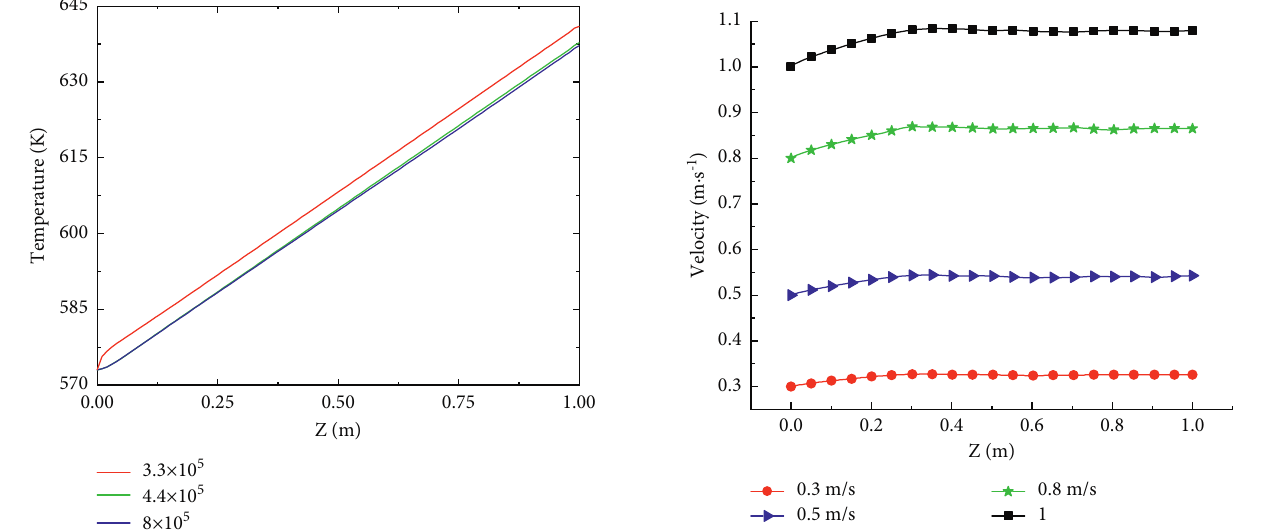
Figure 6: Velocity variation along the axial direction at different velocities.